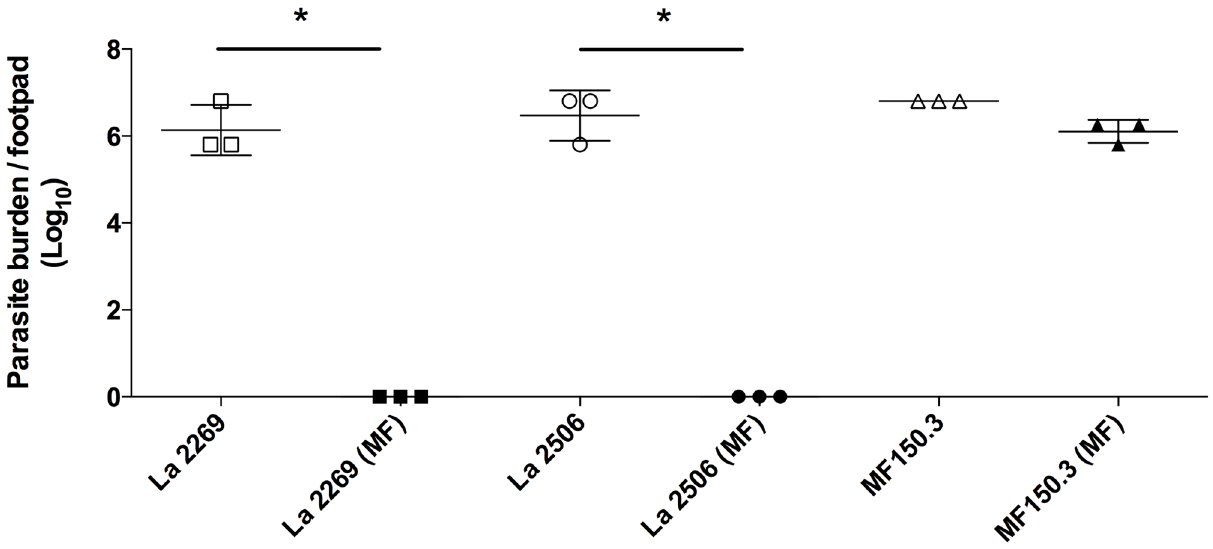
Figure 5. Effect of MF treatment on parasite burden in mice infected with L.amazonensis M2269, 2506 or the MF150.3-1 mutant line. Parasite burden was determined by limiting dilution at week 8 post-infection (one week after the end of MF treatment, for the MF-treated group) in 3 animals from each of the groups shown in Figure 4. Treated and untreated animals are represented by filled and open symbols respectively. Statistical analysis was performed with One Way ANOVA, followed by the Tukey post-test. * p ,